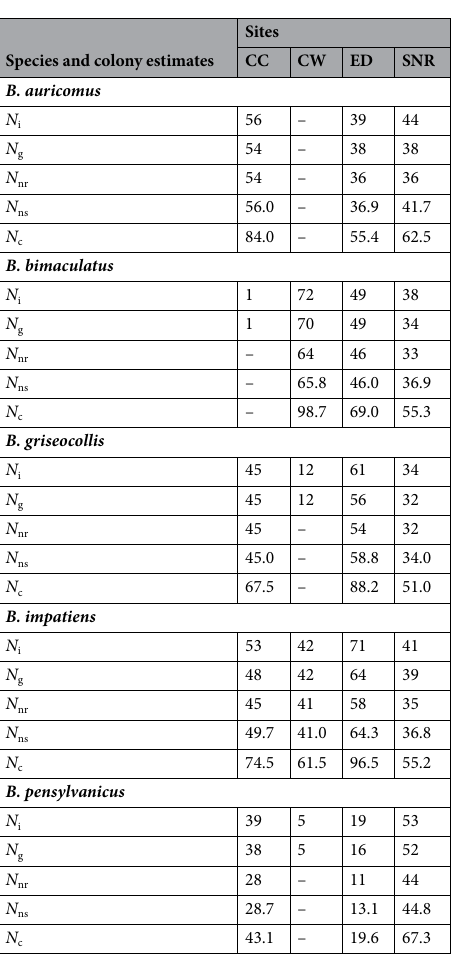
Table 1. Colony density estimates for bumble bee ( Bombus spp.) subpopulations throughout the greater Saint Louis region in 2018. N i is the total number of sampled females, N g is the number of successfully genotyped females, N nr is the number of colonies detected from genotyping, N ns is the number of colonies standardized for genotyping success, and N c is colony density. Colony numbers were not calculated for populations with 15 or fewer successfully genotyped females. CC Calvary Cemetery, CW Castlewood State Park, ED EarthDance Farms, SNR Shaw Nature